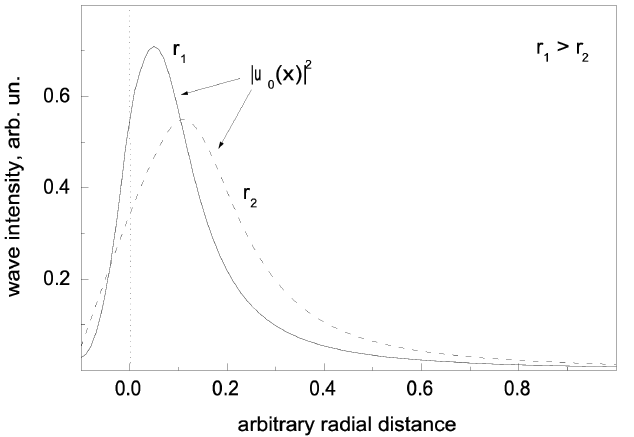
Figure 7. The radial distributions of main radiation mode for capillaries of various radii. The radius decrease results in a shift of the maximum towards the capillary center. The wall surface position is shown by the dotted line (reproduced from